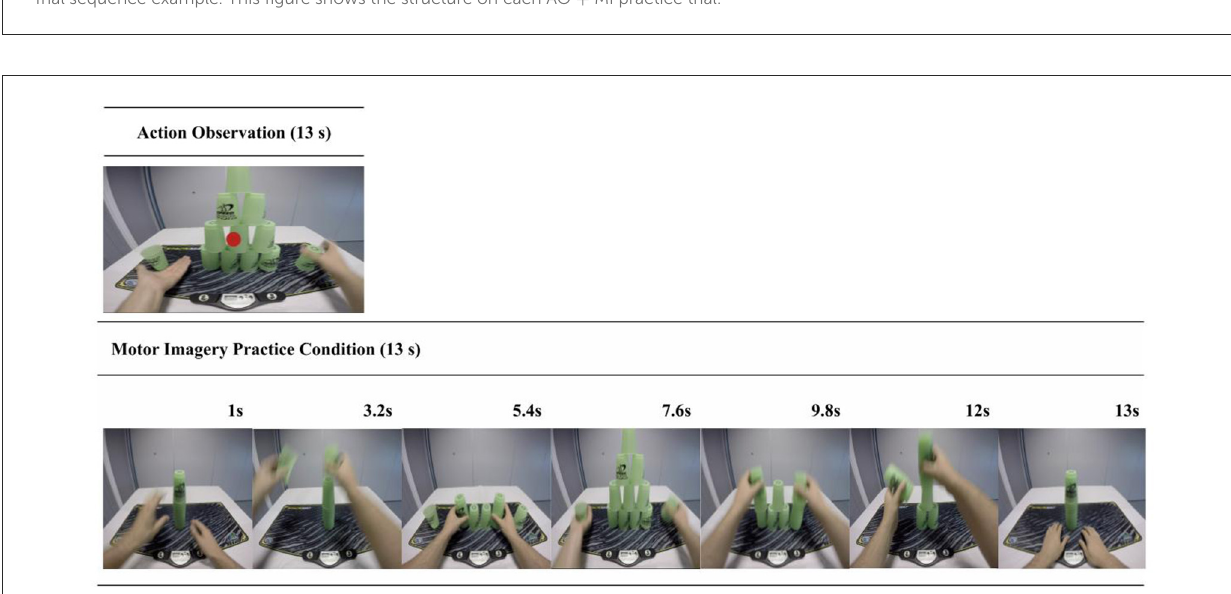
FIGURE2 Trial sequence example. This figure shows the structure on each AO + MI practice trial.